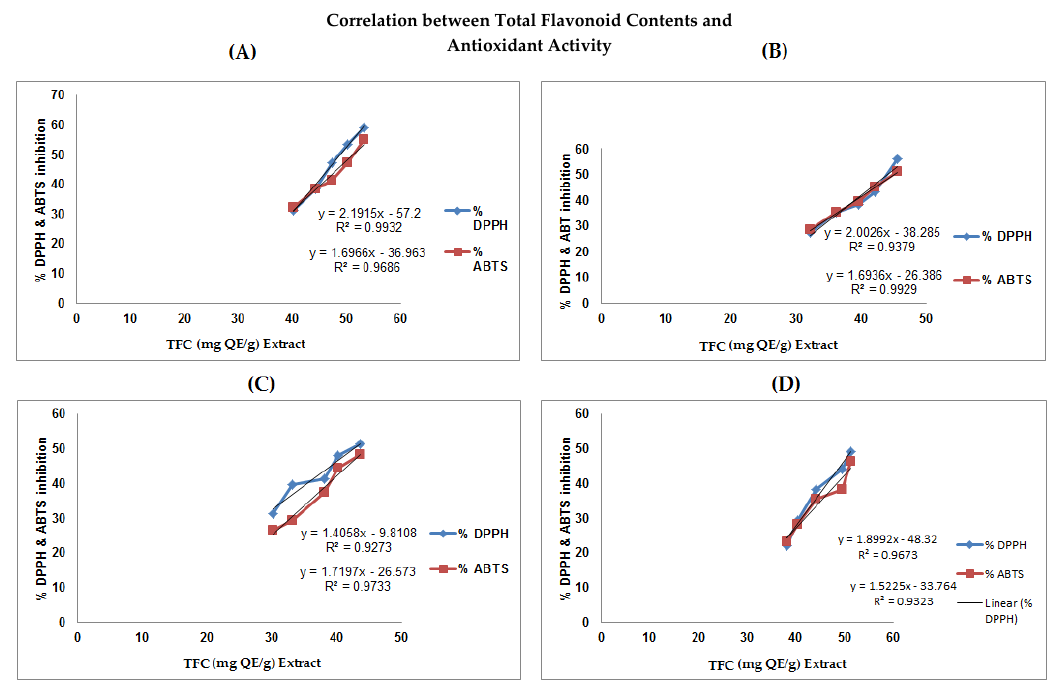
Figure 3. Correlation between total flavonoid in the methanolic extracts of A. nitida various parts (leaves, stem bark, seeds, and roots) content versus percent antioxidant activity. The regression values are; ( A ) leaves (DPPH, R 2 = 0. 9932; ABTS, R 2 = 0.9686), ( B ) stem bark (DPPH, R 2 = 0.979; ABTS, R 2 = 0.9929), ( C ) seeds (DPPH, R 2 = 0. 9273; ABTS, R 2 = 0.9733), and ( D ) roots (DPPH, R 2 = 0. 9673; ABTS, R 2 = 0.9323).